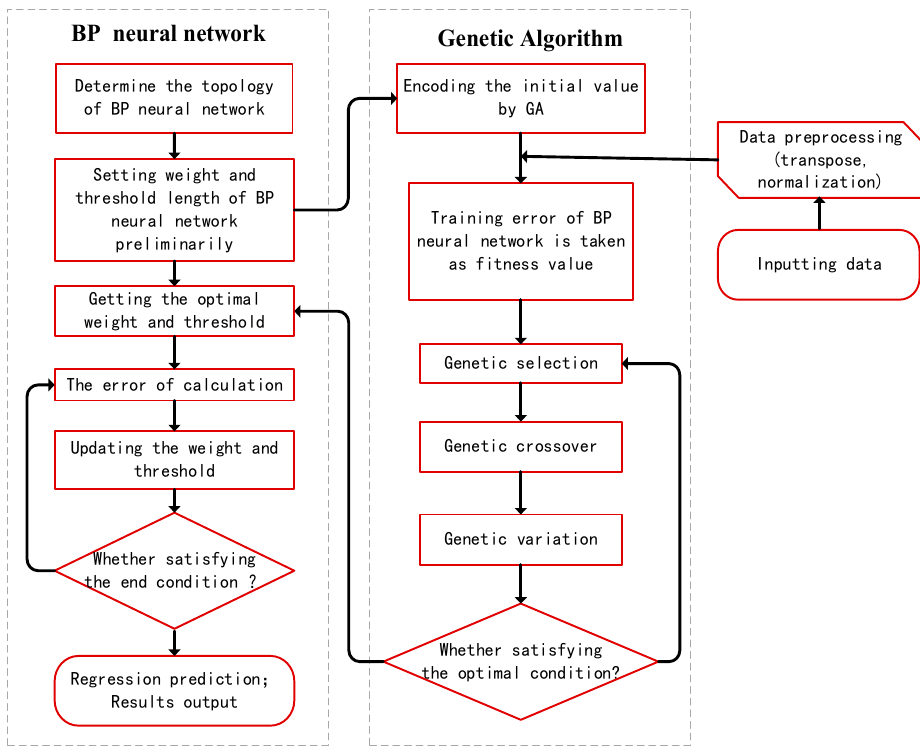
Figure 1. Genetic algorithm (GA)-optimized back propagation (BP) algorithm flow.